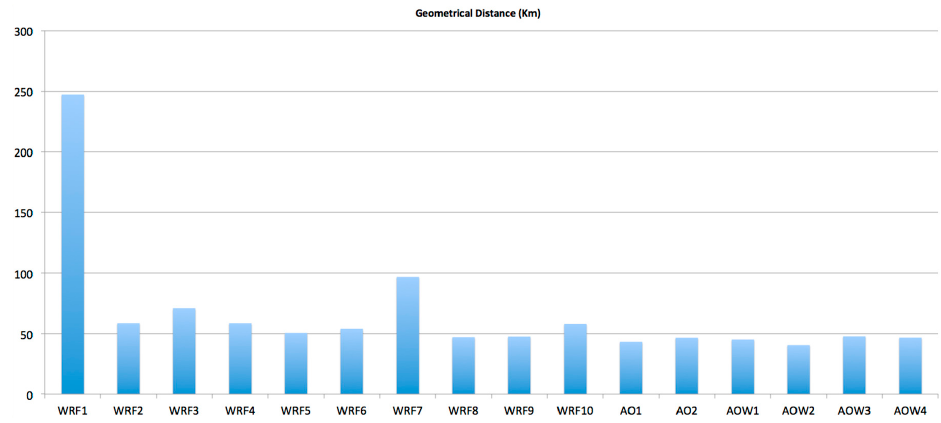
Atmosphere 2017 , 8 , 92 13 of 23 every 3 h. Values of pressure minimum are highlighted by the color of the dots. The black arrows show the direction of propagation of the Medicane. In the different panels we can observe the trajectories resulting from the various runs, compared with the trajectory obtained from the satellite, and the trajectory proposed by the NOAA. Panels ( a–g ): runs WRF1-7 (atmosphere standalone). Panel ( h ): runs WRF5 and WRF8 (MYJ and MYNN PBL). Panel ( i ): runs WRF5 (with MYJ) and WRF9 (WRF with SST decreased by 3 °C). Panel ( l ): runs WRF5, WRF10 (with high resolution SST from MFS- system), AO1 and AOW1 (AO and AOW with MYJ PBL scheme). Panel ( m ): runs WRF8, AO2 and Figure 12. Average geometric distance between simulated and observed trajectories (km). AOW2, using MYNN PBL scheme. Panel ( n ): runs AOW1, AOW3, AOW4 using the different surface Figure 8. Average geometric distance between simulated and observed trajectories (km). roughness schemes (OOST, TY, DRE).